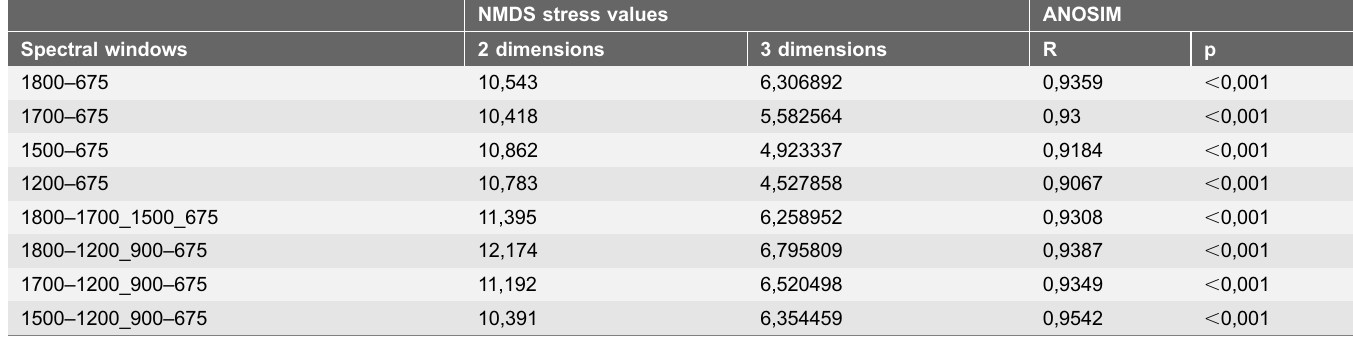
Table 1. Non-metric multidimensional scaling (NMDS) stress values for models with two and three dimensions and analysis of similarities (ANOSIM) R- values and their significance (p) for strains differentiation of five spectral windows